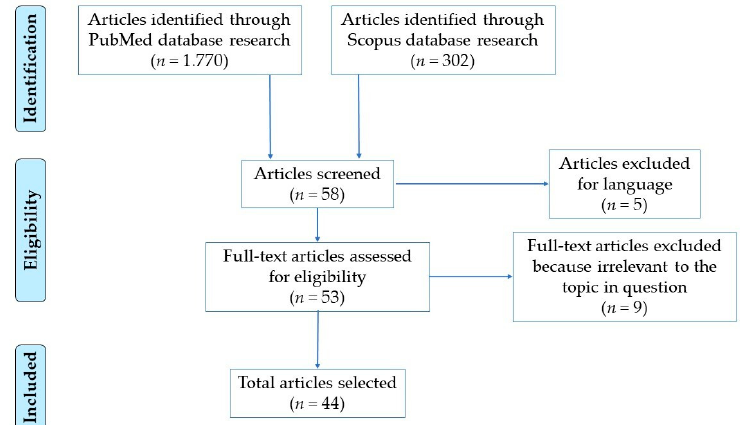
Figure 1. Research flowchart.